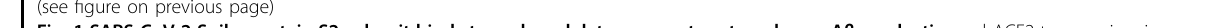
Fig. 1 SARS-CoV-2 Spike protein S2 subunit binds to and modulates γ -secretase to enhance A β production. a hACE2 transgenic mice were intranasally (i.n. ) infected by prototyped SARS-CoV-2. Brain cortical or hippocampal tissues were collected for immuno fl uorescence (7 or 30 dpi) and RNA-seq analysis (30 dpi). b Enrichment analysis of representative biological processes in the hippocampal RNA-seq data at 30 dpi in a . c Expression pattern of representative genes within the categorized gene ontology as indicated. d – g co-IP assays of anti- fl ag monoclonal antibody in HEK293T cells transfected with vector, S-S1- fl ag or S-S2- fl ag, together with myc-tagged PEN-2 ( d ), APH-1 ( e ), PS1 ( f ), and NCT ( g ). h co-IP assays of anti- fl ag monoclonal antibody in HEK293T cells co-transfected with myc-tagged PEN-2, APH-1, PS1 and NCT, together with S-S2- fl ag. i HEK293T cells were transfected with expression vector of APP-C99 with C-terminal fl ag tag (0.5 μ g) and increasing amount of prototyped S-S2-Flag (0, 0.25, and 0.5 μ g) in 12-well plates for 36 h. j U251-C99 cells were transduced with lentivirus carrying prototyped S-S2-Flag in 12-well plates for 36 h. The production of AICD (red arrows) in i and j was examined by immunoblot analysis. k HEK293T cells were co-transfected with expression vector of APP- C99 with C-terminal fl ag tag (APP-C99-Flag, 0.5 μ g) and increasing amount (0, 0.25 or 0.5 μ g) of Omicron S-S2-Flag in 12-well plates for 36 h. The production of AICD (red arrow) from APP-C99 was detected by immunoblot analysis. l Mouse primary neurons were isolated from embryonic (E18.5) brains and cultured in 24-well plates. Neurons were transduced with lentivirus carrying empty vector (vector), prototyped S-S2, M, or IFITM3 for 36 h. The A β 40 (left) and A β 42 (right) levels in the supernatants were quanti fi ed by ELISA. Means ± SD; n = 4; n.s., not signi fi cant; * P < 0.05; ** P < 0.01, one- way ANOVA with Bonferroni ’ s post hoc test. m Representative anti-A β antibody staining of cortical (CTX) and hippocampal (HP) sections in APP/ PS1 Δ E9 mice with AAV delivery of prototyped S-S2 (AAV-S-S2) and AAV control (AAV-Vector). Scale bar, 500 μ m. n Quantitative analysis of the number of A β plaques and the percentage of area covered by A β plaques in cortical (upper) and hippocampal (bottom) tissues in m . Each slide was counted for A β plaque number and A β plaque area via ImageJ software, and the percentage of the plaque area was calculated. o Representative immuno fl uorescence of microglial marker TMEM119 protein in hippocampal sections of AAV-S-S2 or AAV-Vector. Scale bar, 30 μ m. p Quanti fi cation of percentage of TMEM119 + area in o . Statistical analyses for n and p , Means ± SD; n = 6 (AAV-Vector group) or n = 7 (AAV-S-S2 group); * P < 0.05; ** P < 0.01 ; *** P < 0.001, Student ’ s t